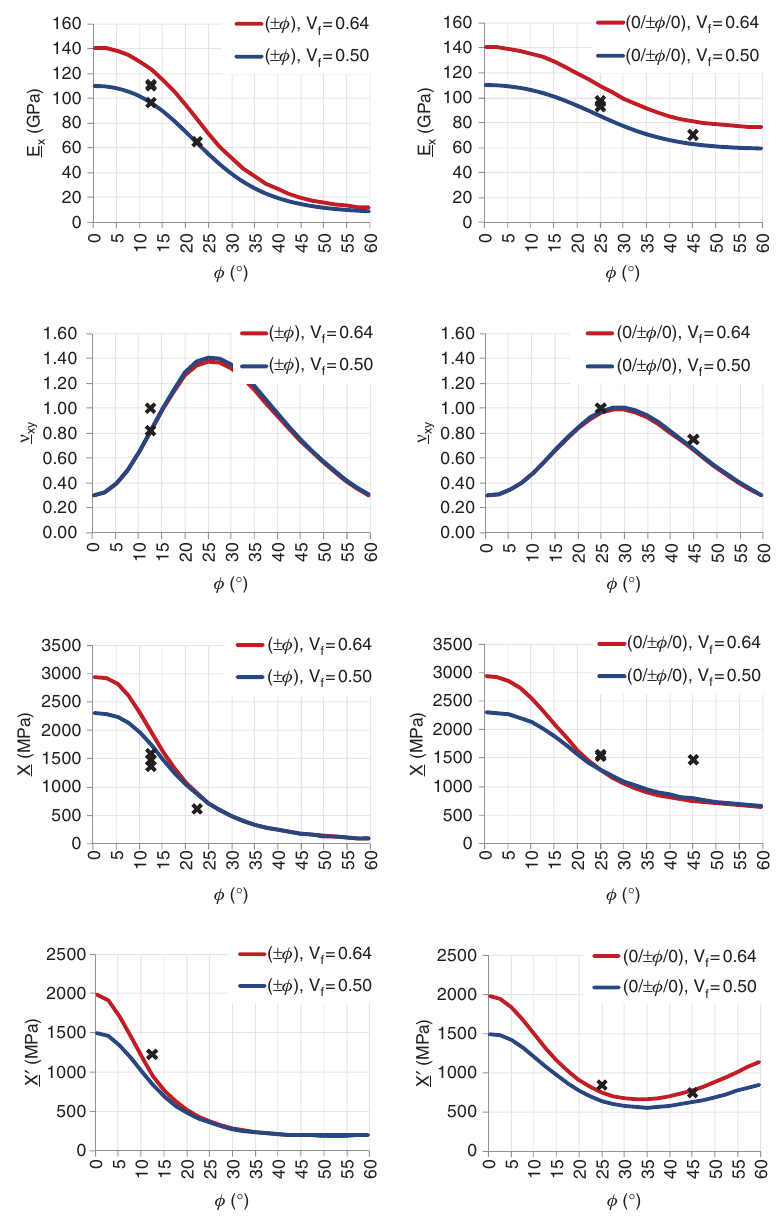
Figure 4: Basic stiffness and strength predictions for T700/Epoxy ( ± φ ) and (0/ ± φ /0) C-ply™ laminates. Test data from ( ± 12.5), ( ± 22.5), (0/ ± 25/0), and (0/ ± 45/0) type laminates